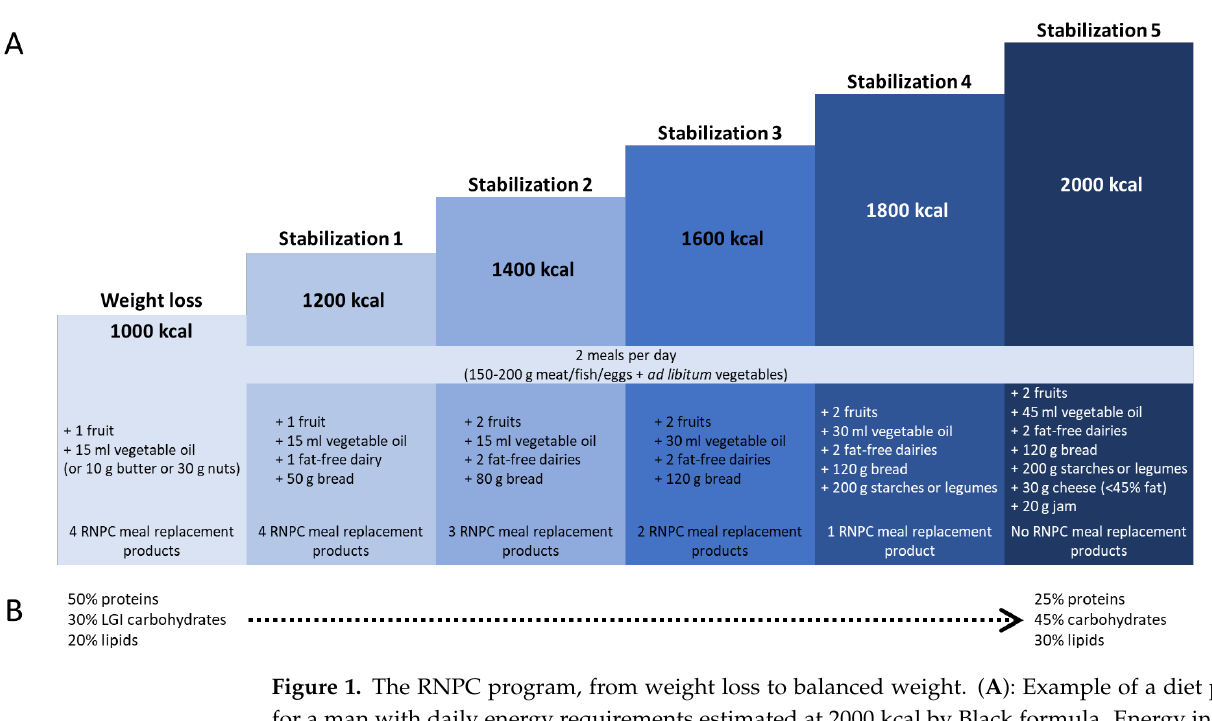
Figure 1. The RNPC program, from weight loss to balanced weight. ( A ): Example of a diet plan for a man with daily energy requirements estimated at 2000 kcal by Black formula. Energy intake and food consumed daily increase throughout the RNPC program, while the number of RNPC meal replacement products decreases. ( B ): Evolution of macronutrient distribution from weight loss to maintenance phase.